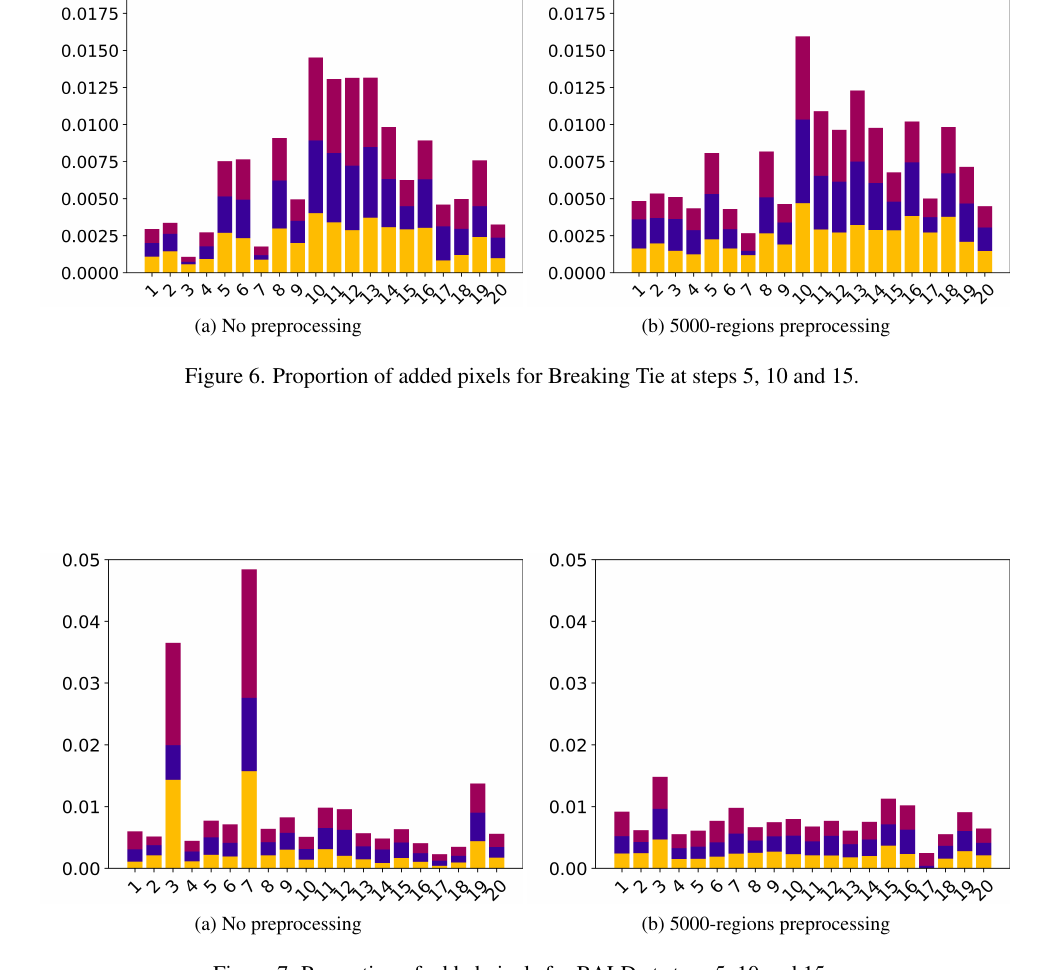
Figure 7. Proportion of added pixels for BALD at steps 5, 10 and